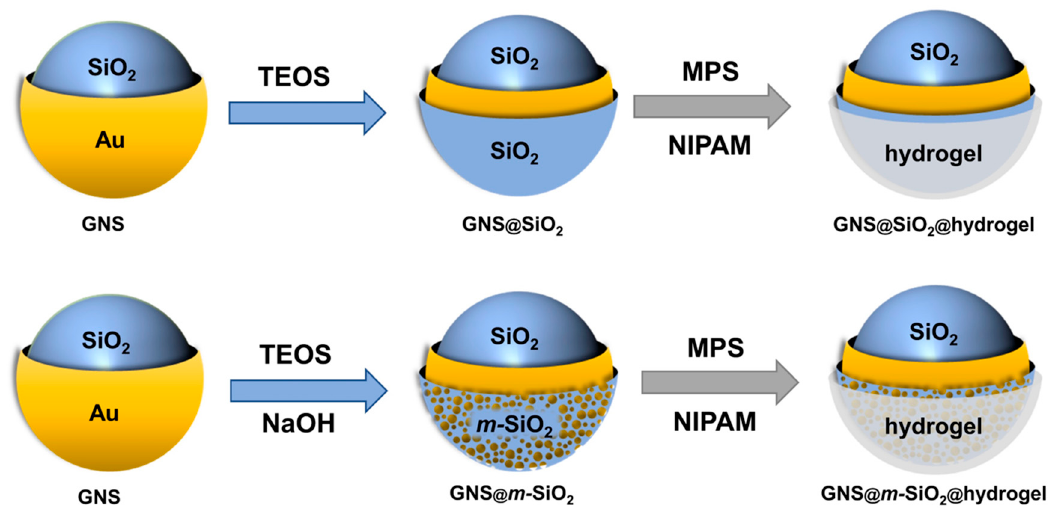
Scheme 1. Synthetic strategy used for the synthesis of hydrogel-encapsulated SiO 2 -coated